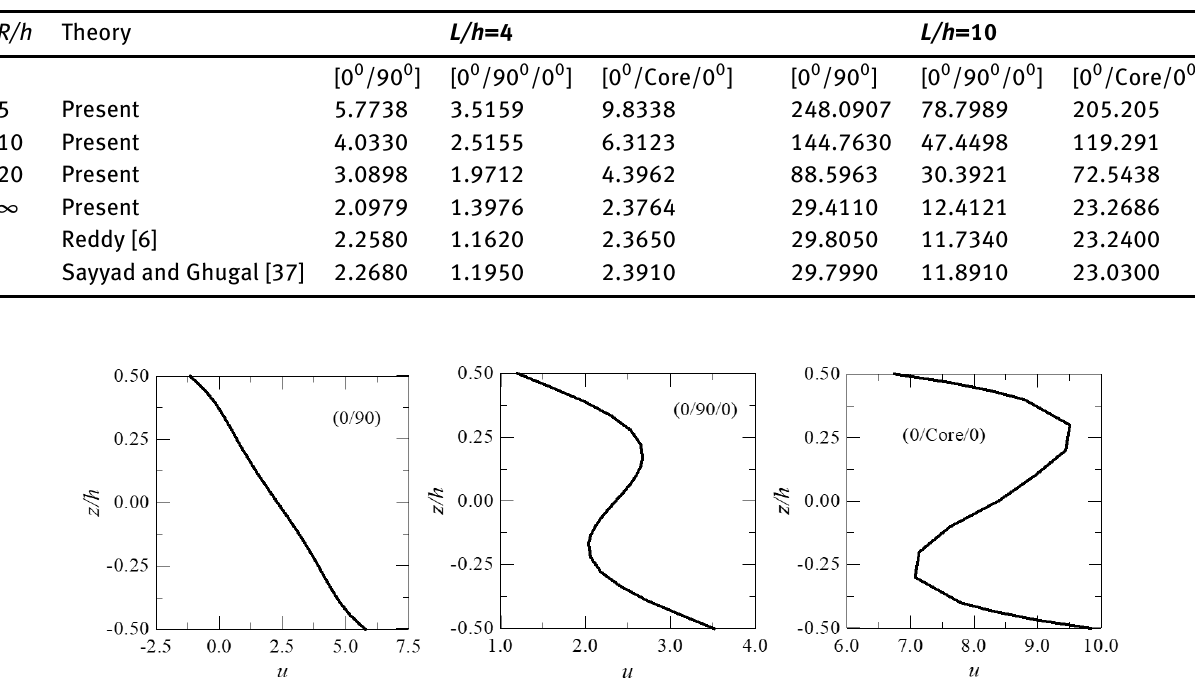
Figure 3: Through-the-thickness variations of axial displacement for laminated and sandwich beams curved in elevation ( L/h= 4, R/h=